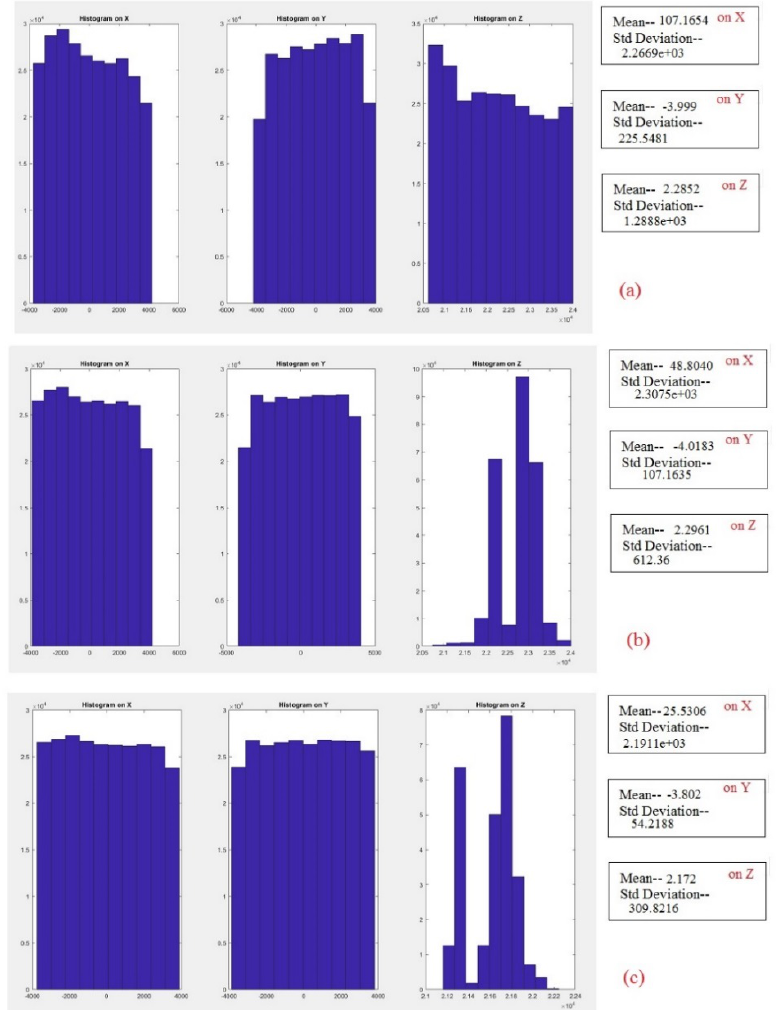
Figure 9. Comparing the histogram of our result with other state-of-the-art methods for image Green (Figure 7). ( a ) Shows the histograms obtained from our 3D point cloud method. ( b ) Indicates the histograms of Perra et al. [5] method for creating 3D point cloud and ( c ) shows the result of Dansereau et al. [28]. From the figure it is obvious that the histograms of our method ( a ) have a more favourable distribution of positions, especially in Z dimension, compared to the two other methods. Table 1. Numerical evaluation of 3D point cloud based on LoD ([number of vertices], [number of faces]). Light Field Image Perra et al. [5] Dansereau et al. [28] Our Method Buildings-Black-fence. Figure 8 [65,264] a , [12,6970] b [62,215] a , [123,056] b [70,568] a , [139,452] b Nature-Flowers. Figure 6 [84,729] a , [165,584] b [72,980] a , [141,069] b [98,245] a , [192,874] b Green. Figure 7 [72,548] a , [142,309] b [73,415] a , [145,977] b [82,579] a , [161,231] b a number of vertices, b number of